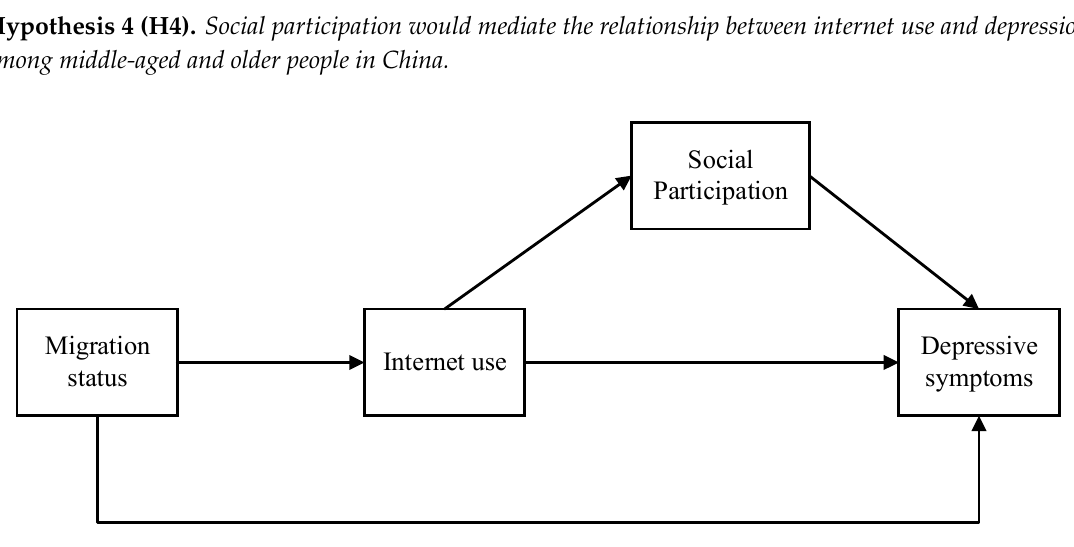
Figure 1. The proposed model including stressors, coping resources, and stress